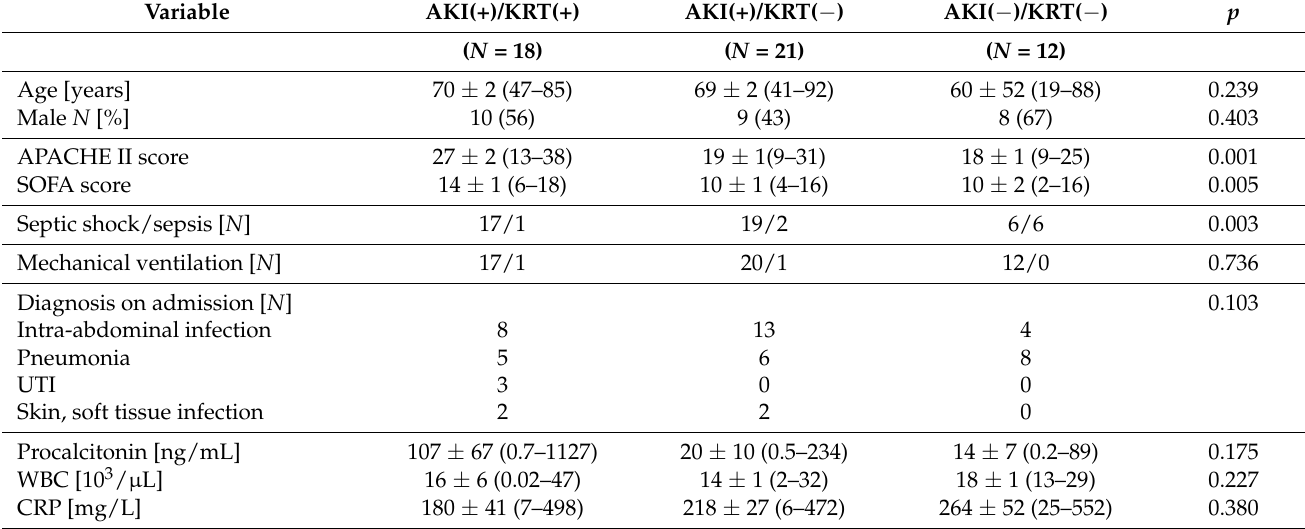
Table 1. Baseline characteristics of patients with sepsis. Patients were divided according to the need for kidney replacement therapy (KRT +/ − ) and a diagnosis of acute kidney injury (AKI +/ − ) on admission to the ICU. The KDIGO AKI guidelines were used for AKI